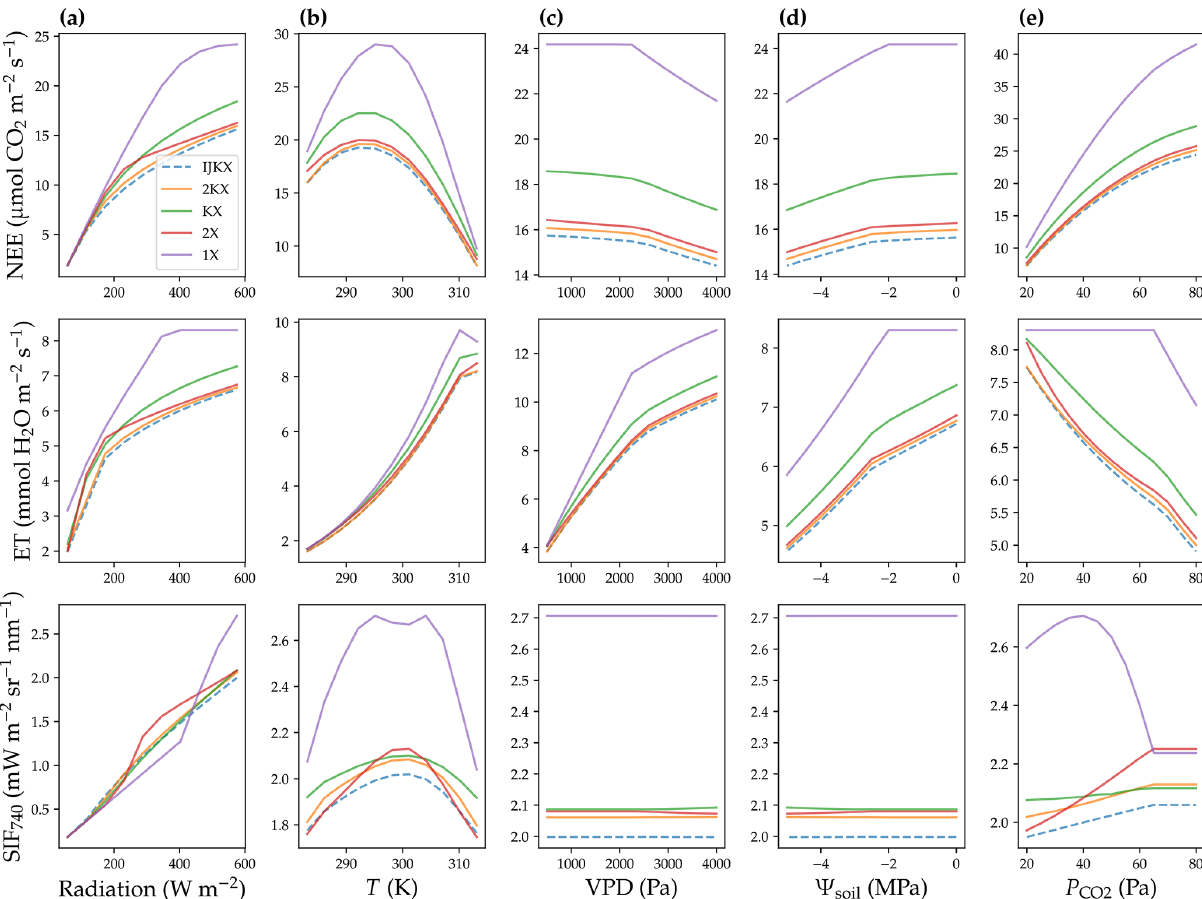
Figure 4. Net ecosystem exchange of CO 2 (NEE, normalized per ground area), evapotranspiration rate (ET, normalized per ground area), and solar-induced fluorescence (SIF) responses to changes in environmental cues. (a) Responses to total radiation. (b) Responses to air and leaf temperature ( T ). (c) Responses to atmospheric-vapor-pressure deficit (VPD). (d) Responses to soil water potential ( (cid:57) soil ). (e) Responses to atmospheric CO 2 partial pressure ( P CO ). This sensitivity analysis was done assuming uniform photosynthetic capacity in the 2